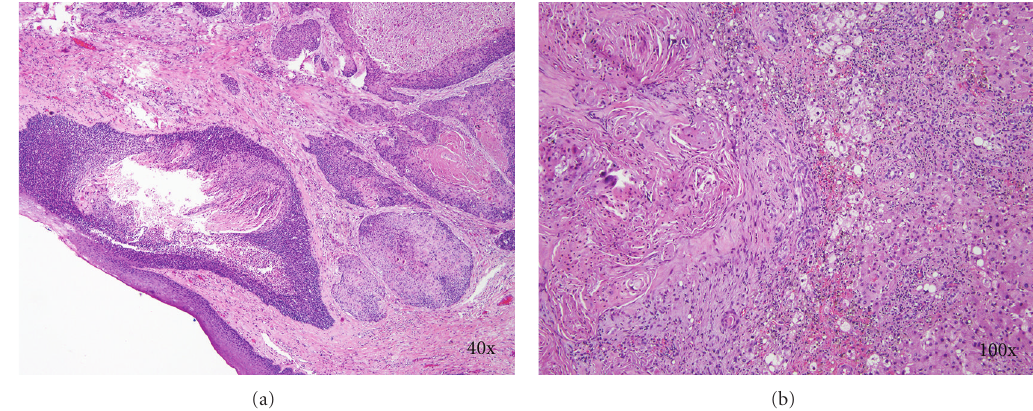
Figure 2: Histologic sections showing squamous cell carcinoma in the APR specimen (a) and the liver resection (b).